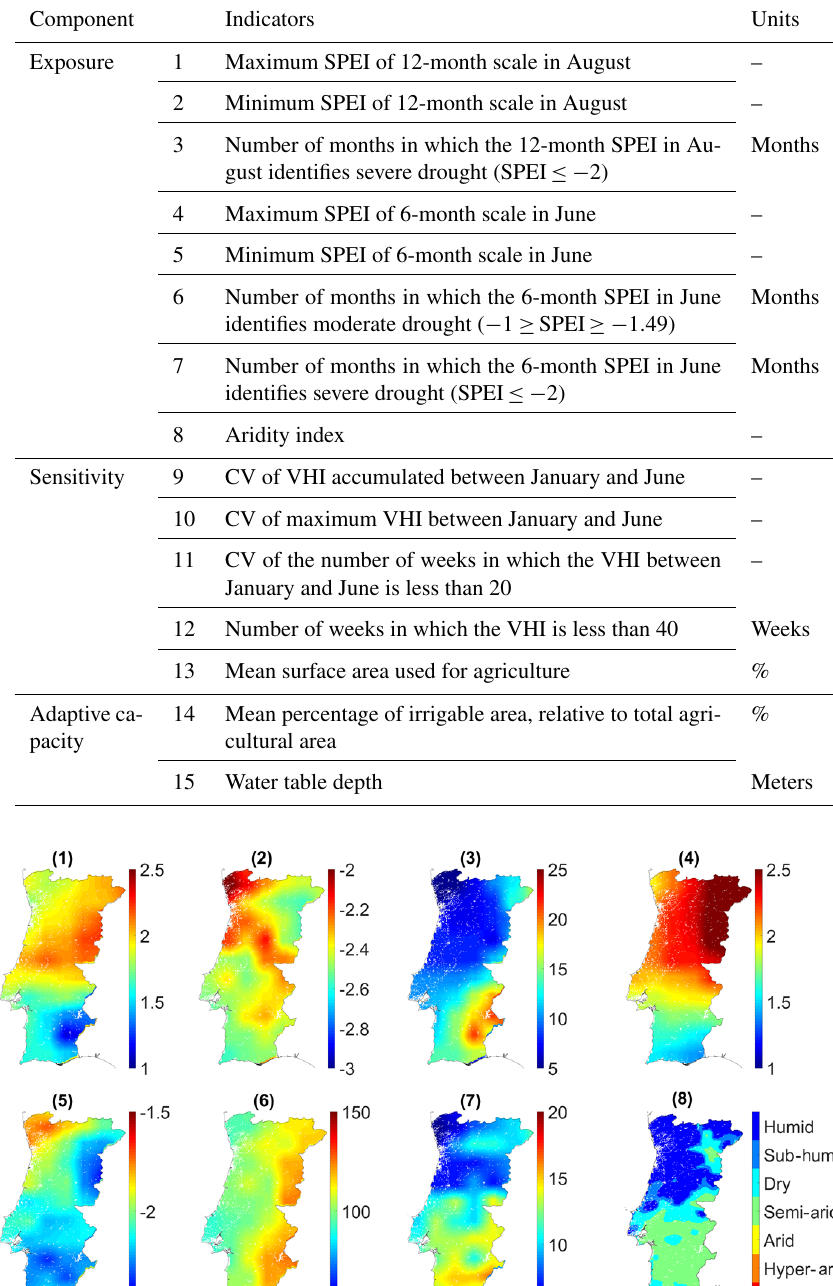
Table 1. Selected indicators.